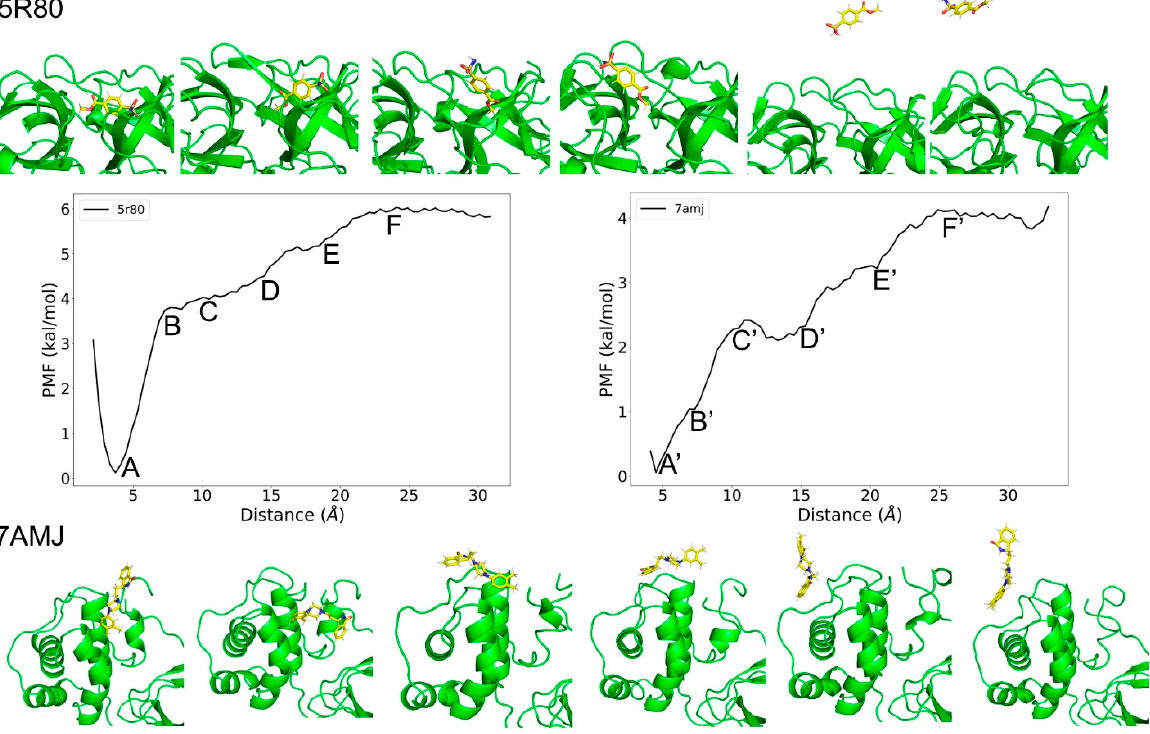
Figure 8. Unbinding processses of ligand RZG (5R80) and ligand RMZ (7AMJ) dissociating from the binding site of M pro .